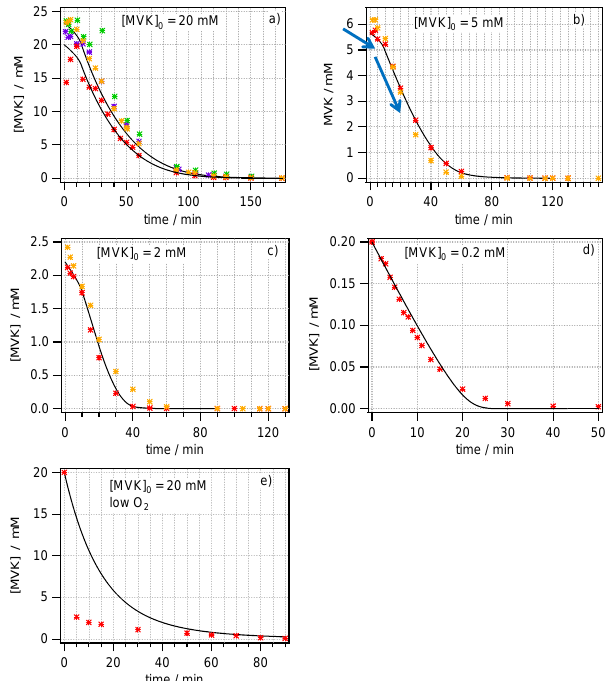
Figure 2. Comparison of experimental (symbols) and model (lines) results using the mechanism listed in Table 1 and j H four initial MVK concentrations (a) ∼ 20mM (fit to red and orange symbols); (b) ∼ 5mM; (c) ∼ 2mM; (d) ∼ 0.2mM. (e) [MVK] 0 = 20mM; low oxygen concentration. Symbols of different colors de- note replicate experiments.